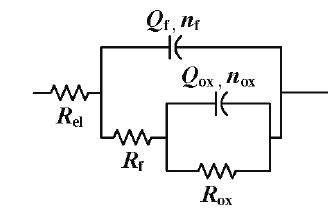
Fig. 9 – Equivalent electrical circuits used for fitting the EIS spectra in Fig. 8 and Fig. 10